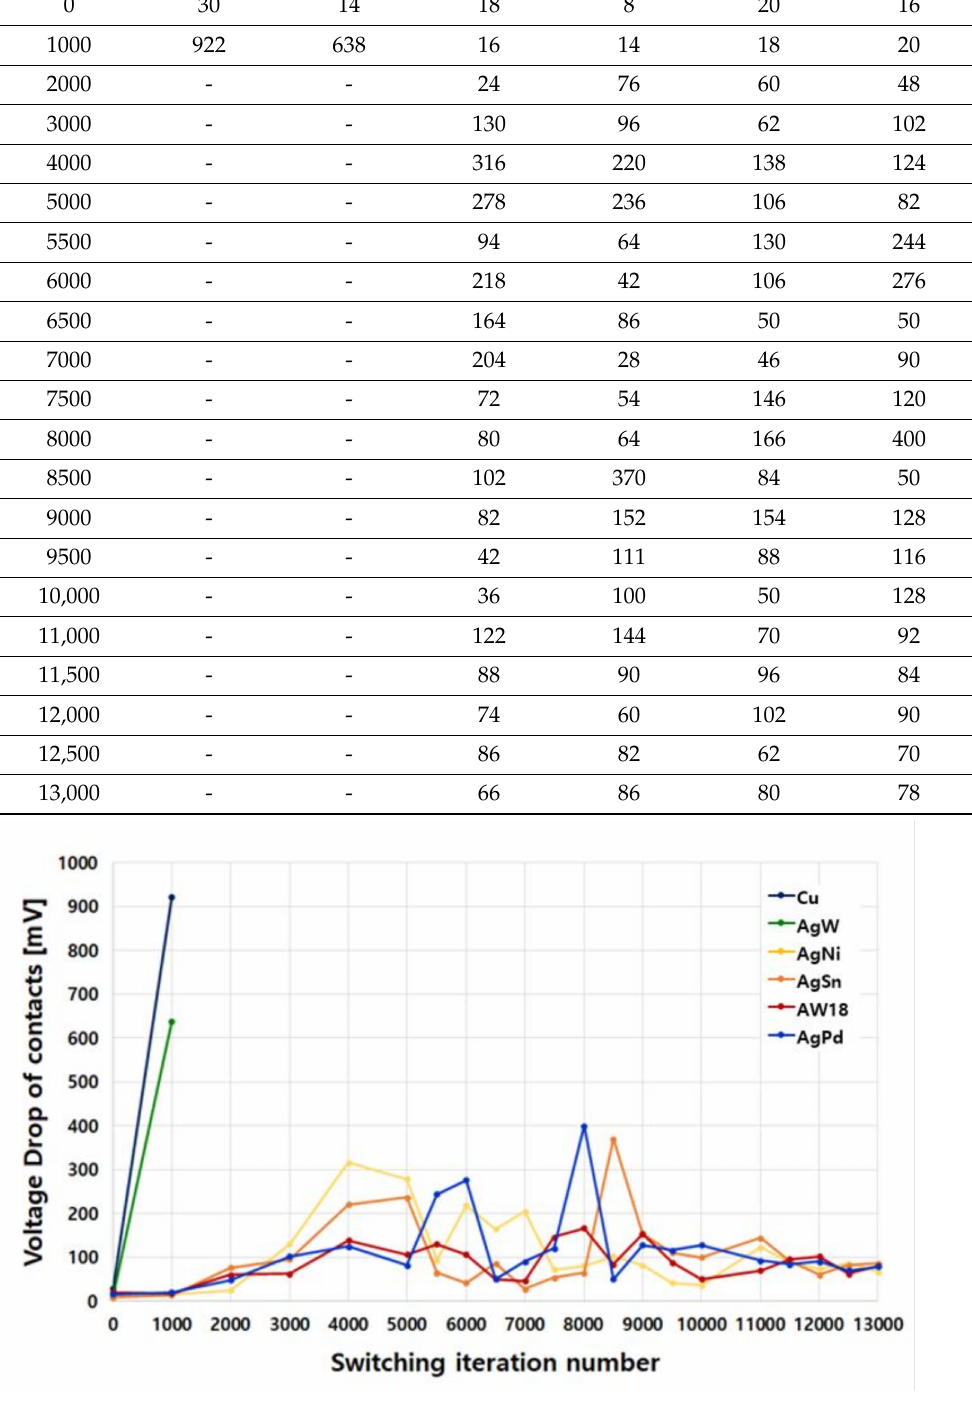
Figure 5. Voltage drop of electrode contact according to electrode material under 400 V/5 A load